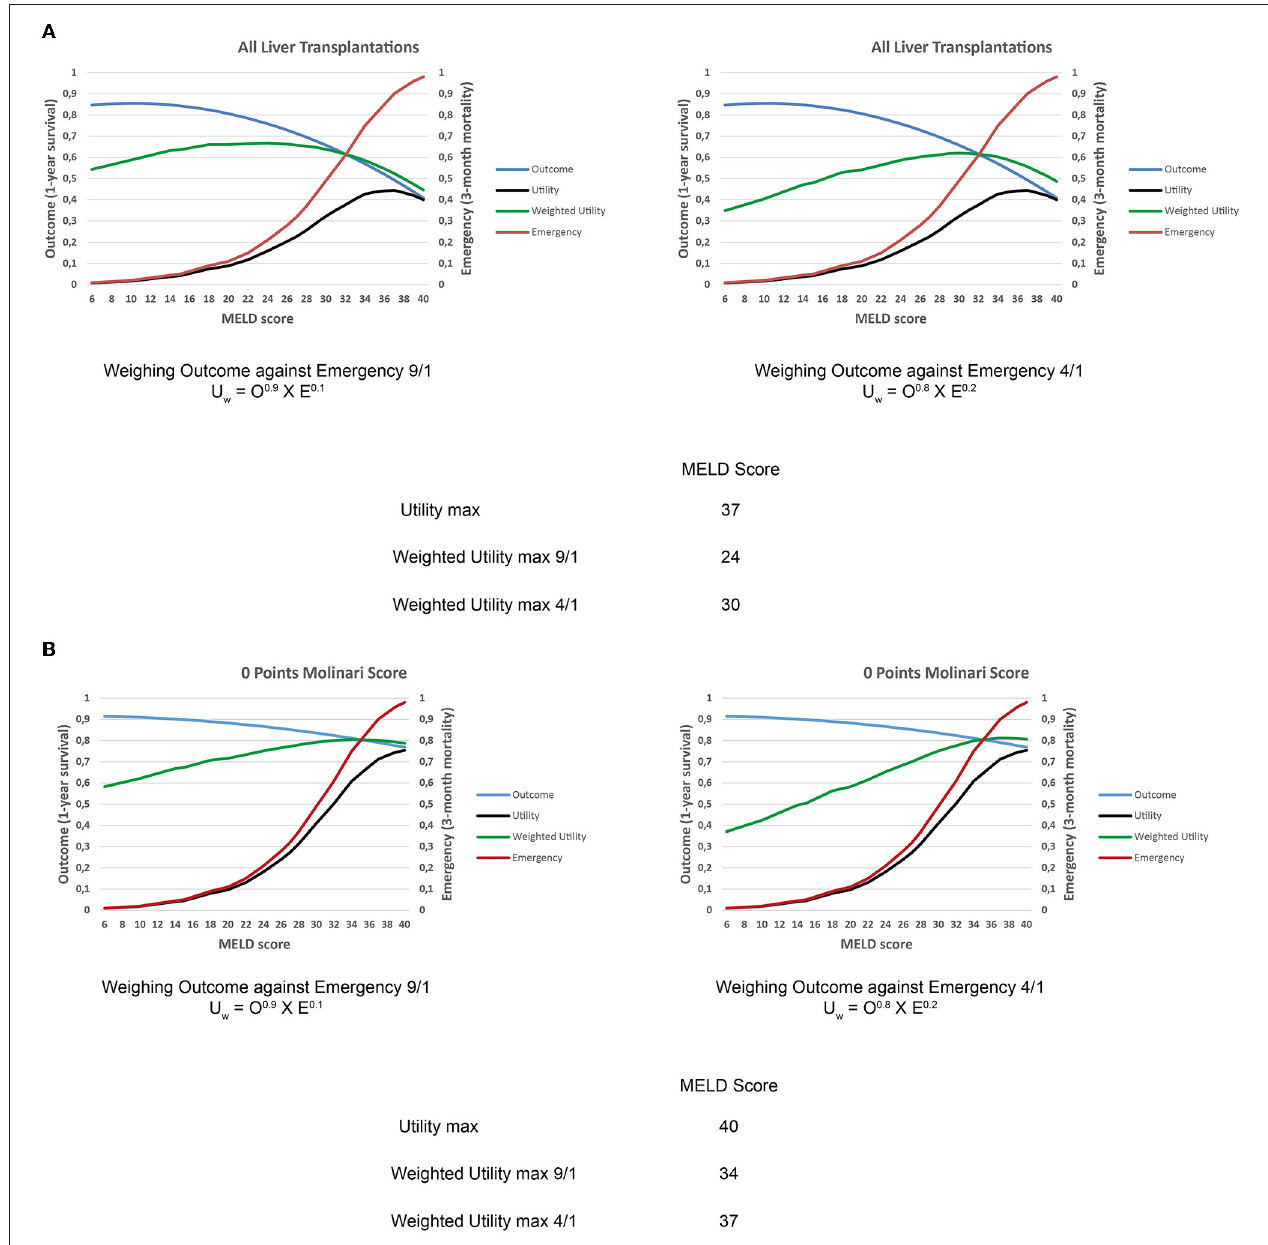
point-based system in Molinari scoring style is presented in Table 2 . Recipient diabetic status, although predictive of overall mortality by Cox regression analysis, did not achieve significance for 90-day mortality (data not shown). This is consistent with previous studies (20, 21) and with the observation that poorly controlled blood glucose levels are predominantly associated with cardiovascular and neurological